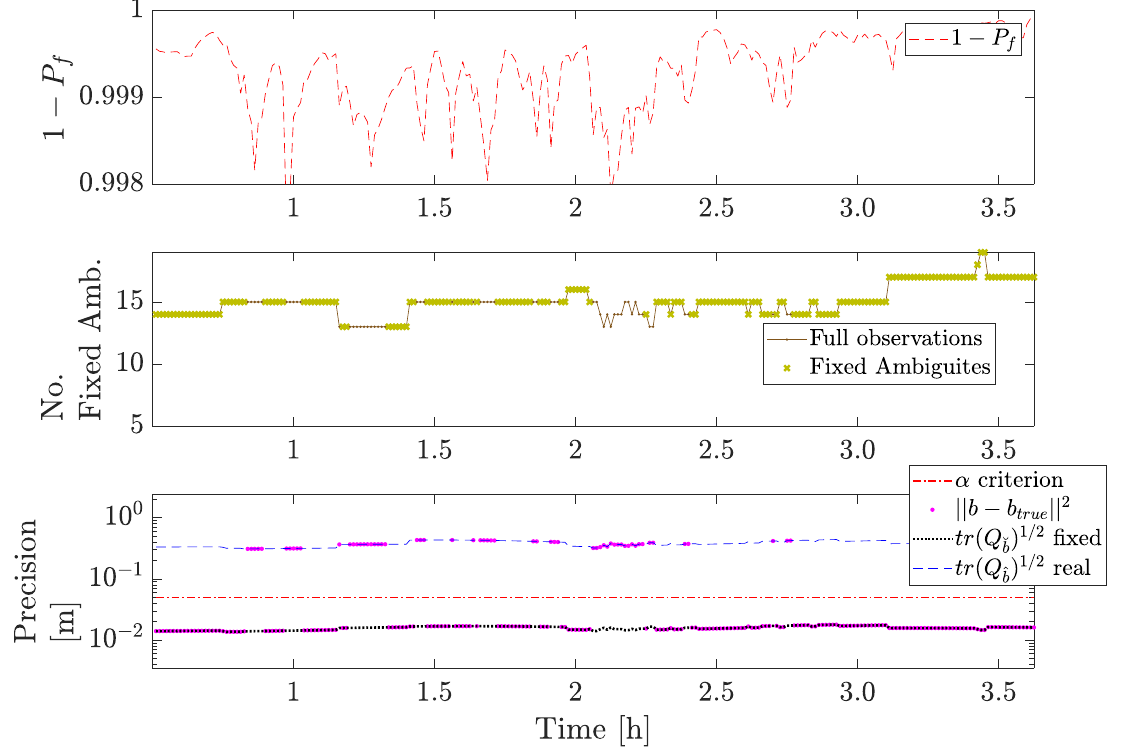
Figure 8. GPS (L1 + L2) + GAL (E1 + E5a) performance comparative for a FAR